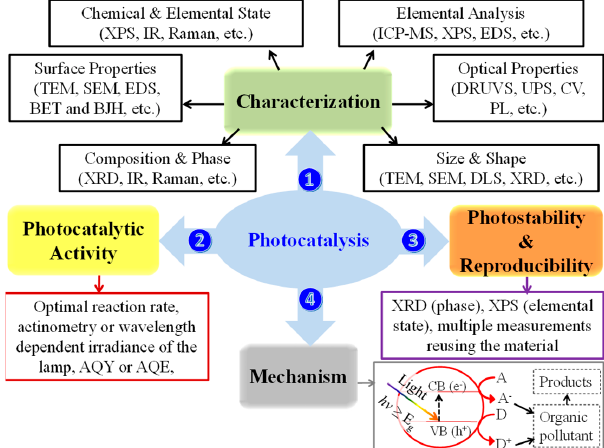
Figure 1. Representation of the four features to report in heterogeneous photocatalysis: (1) material characterization, (2) evaluation of photocatalytic activity, (3) determination of the photocatalyst stability and data reproducibility, and (4) proposal of a mechanism. Key for abbreviations: A, electron acceptor; AQE, apparent quantum efficiency; AQY, apparent quantum yield; BET, Brunauer − Emmett − Teller; BJH, Barrett-Joyner-Halend; CB, conduction band; CV, cyclic voltammetry; D, electron donor; DLS, dynamic light scattering; DRUVS, diffuse reflectance UV-visible spectroscopy; EDS, energy dispersive X-ray spectroscopy; E g , bandgap energy; e − , electron; h + , hole; h ν , photon energy; ICP-MS, inductively coupled plasma mass spectrometry; IR, infrared spectroscopy; PL, photoluminescence spectroscopy; SEM, scanning electron microscopy; TEM, transmission electron microscopy; UPS, ultraviolet photoelectron spectroscopy; VB, valence band; XPS, X-ray photoelectron spectroscopy; and XRD, X-ray diffraction.